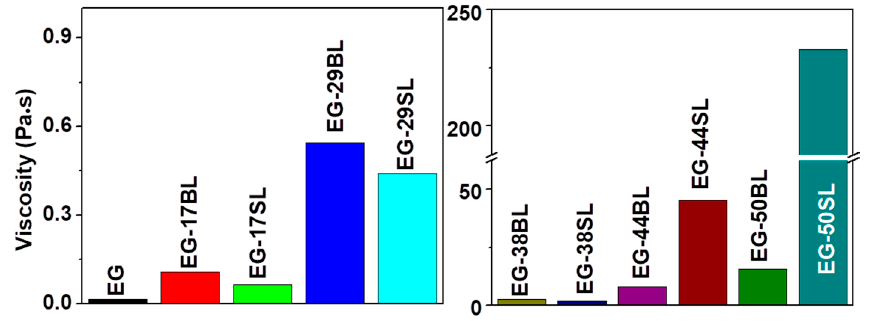
Figure 3. Viscosity of EG-based lubricants.